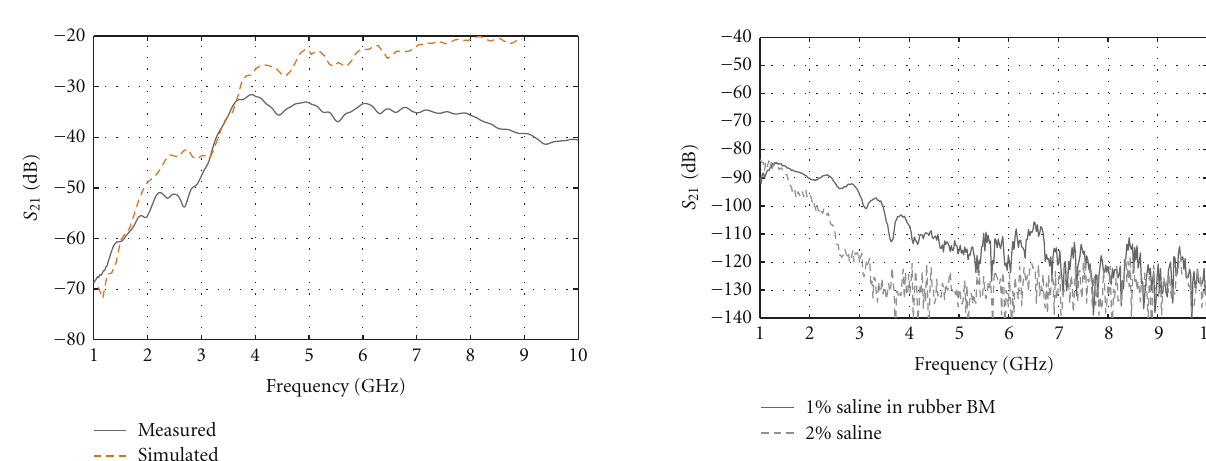
Figure 9: Measured and simulated transmission through the low- loss breast model (100mm diameter).